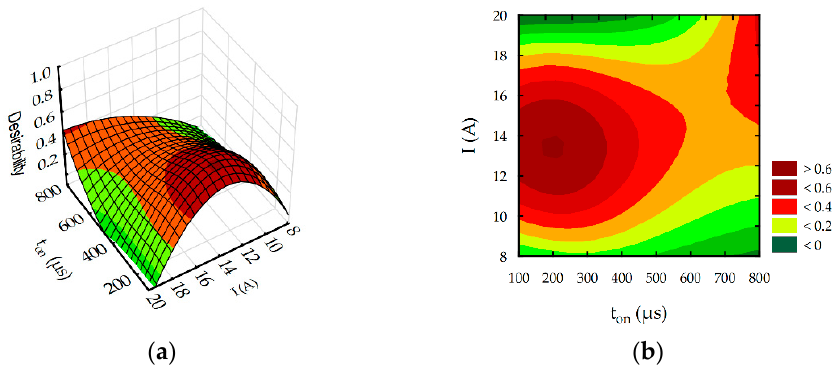
Figure 16. Desirability function for rough-slot EDM optimization: ( a ) response surface and ( b ) contour plots.